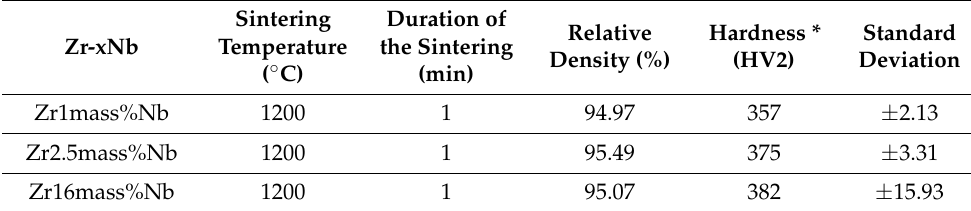
Table 5. The KOBO extrusion process parameters, relatively densities, hardness of the ex- truded Zr-xNb materials obtained from mixtures with the 1–5 µ m niobium powder, milled in isopropyl alcohol. Temperature Duration of of the the Relative Hardness * Standard Zr-xNb Extrusion Extrusion Density (%) (HV2) Deviation ( ◦ C) (min) Zr 400 0.2 97.95 397 ± 12.12 Zr2.5mass%Nb 400 0.2 97.31 425 ± 7.84 Zr16mass%Nb 400 0.2 97.84 410 ±